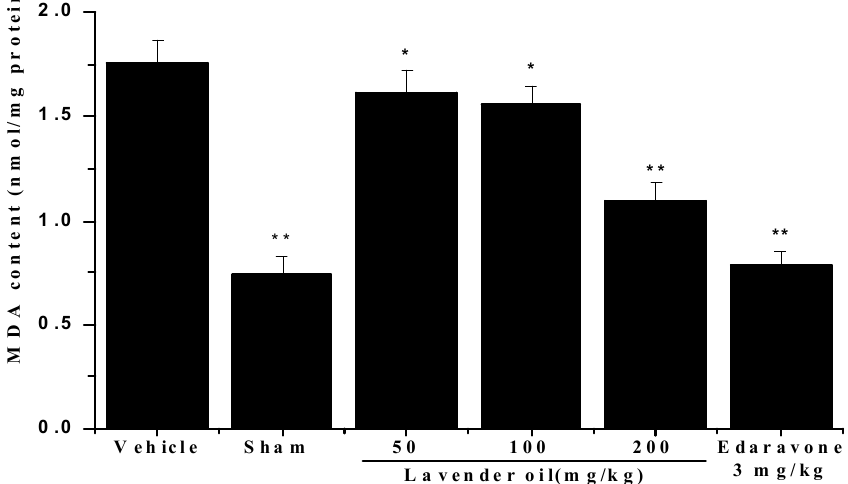
Figure 4. MDA content measured after 22 h of reperfusion.